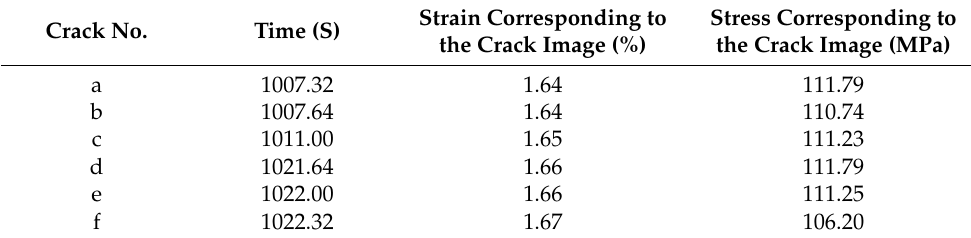
Table 3. Stress and strain values corresponding to the crack static